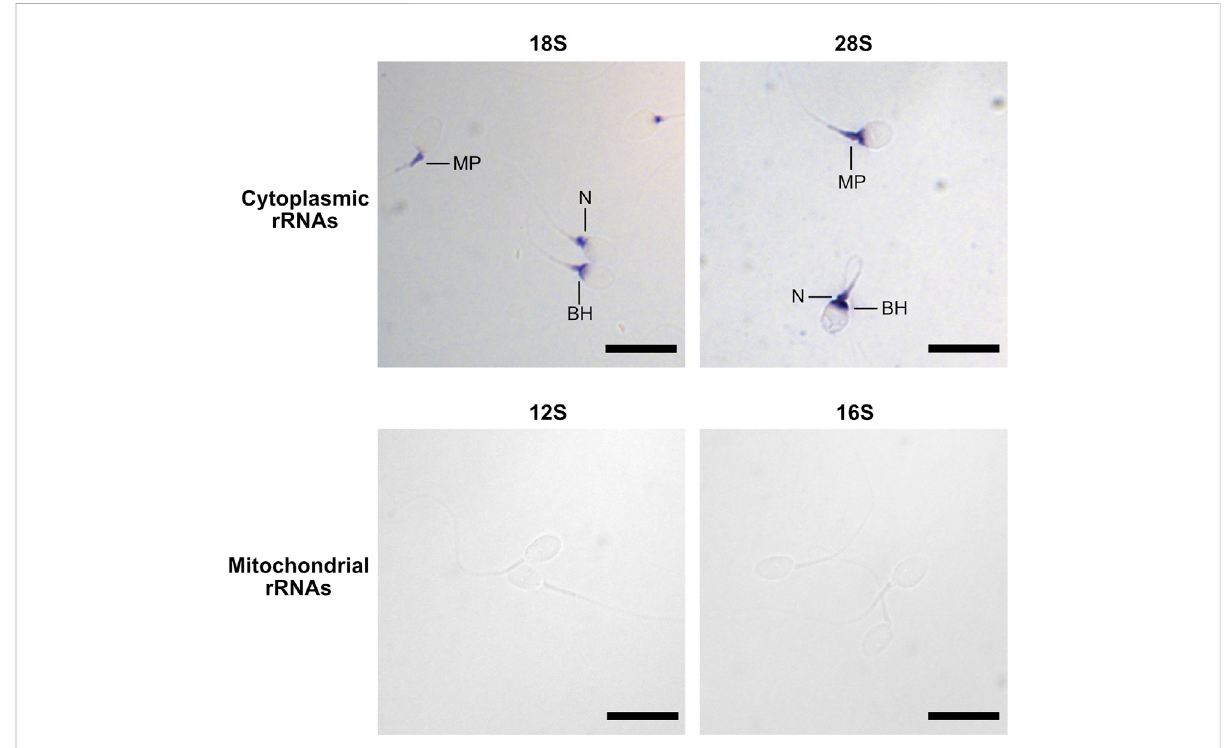
FIGURE 2 Localization of rRNAs in human spermatozoa by in situ hybridization. Spermatozoa were labelled using antisense RNA probes targeting 28S, 18S, 16S, and 12S rRNAs. Scale bar: 10 µm. BH: base of the Head, MP: Midpiece, N: